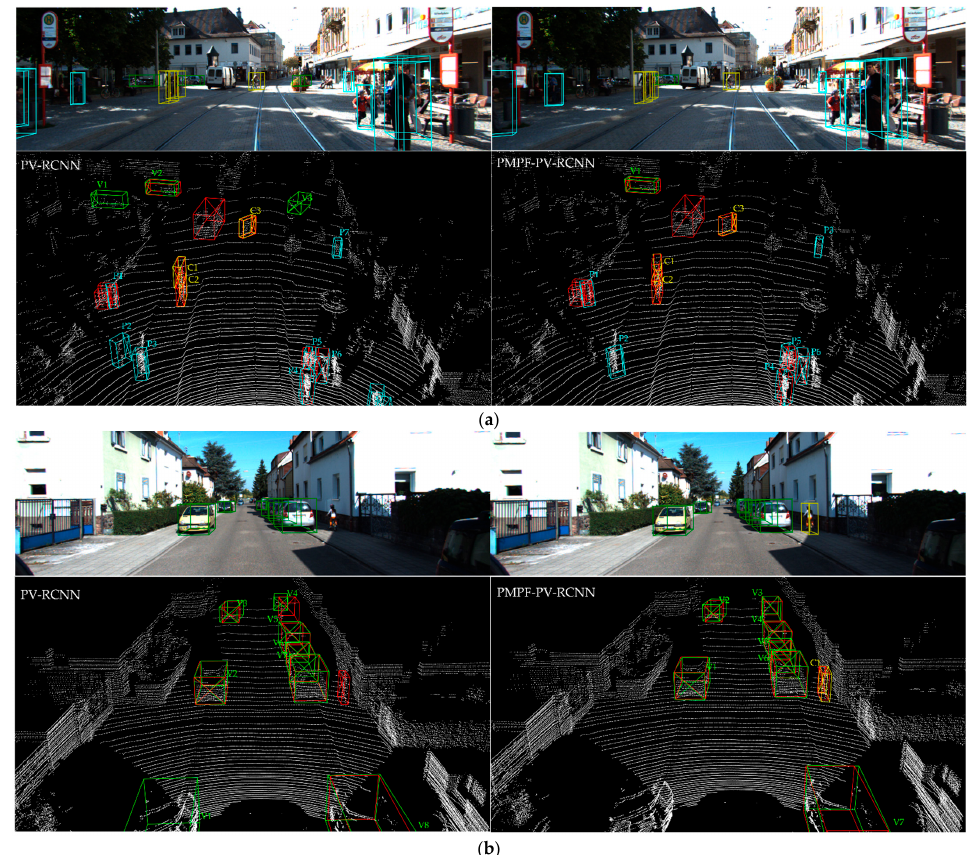
Figure 5. Qualitative analysis results of the KITTI 3D object detection dataset. We created two comparison figures. ( a ) Compared to PV-RCNN, PMPF-PV-RCNN reduces false positive detection in complex scenarios. ( b ) Compared to PV-RCNN, PMPF-PV-RCNN reduces true positive misses in general scenarios. For each comparison, the 3D object detection results for the image are on the top and point cloud on the bottom, where the LiDAR-only detector (PV-RCNN) results are on the left and the results of PMPF are on the Right. The boxes drawn in the diagram are green for car, light blue for pedestrian, yellow for cyclist, and red for ground truth and the letter and digit denote the classification and ID of each box with “V” for car, “P” for pedestrian, and “C” for cyclist. In Figure 6, we provide a qualitative comparison from PointPainting [9] with the PMPF method for a scene that not only contains three classes of targets, but also has significant overlap and crossover in some of the targets. First, we focus on the two false